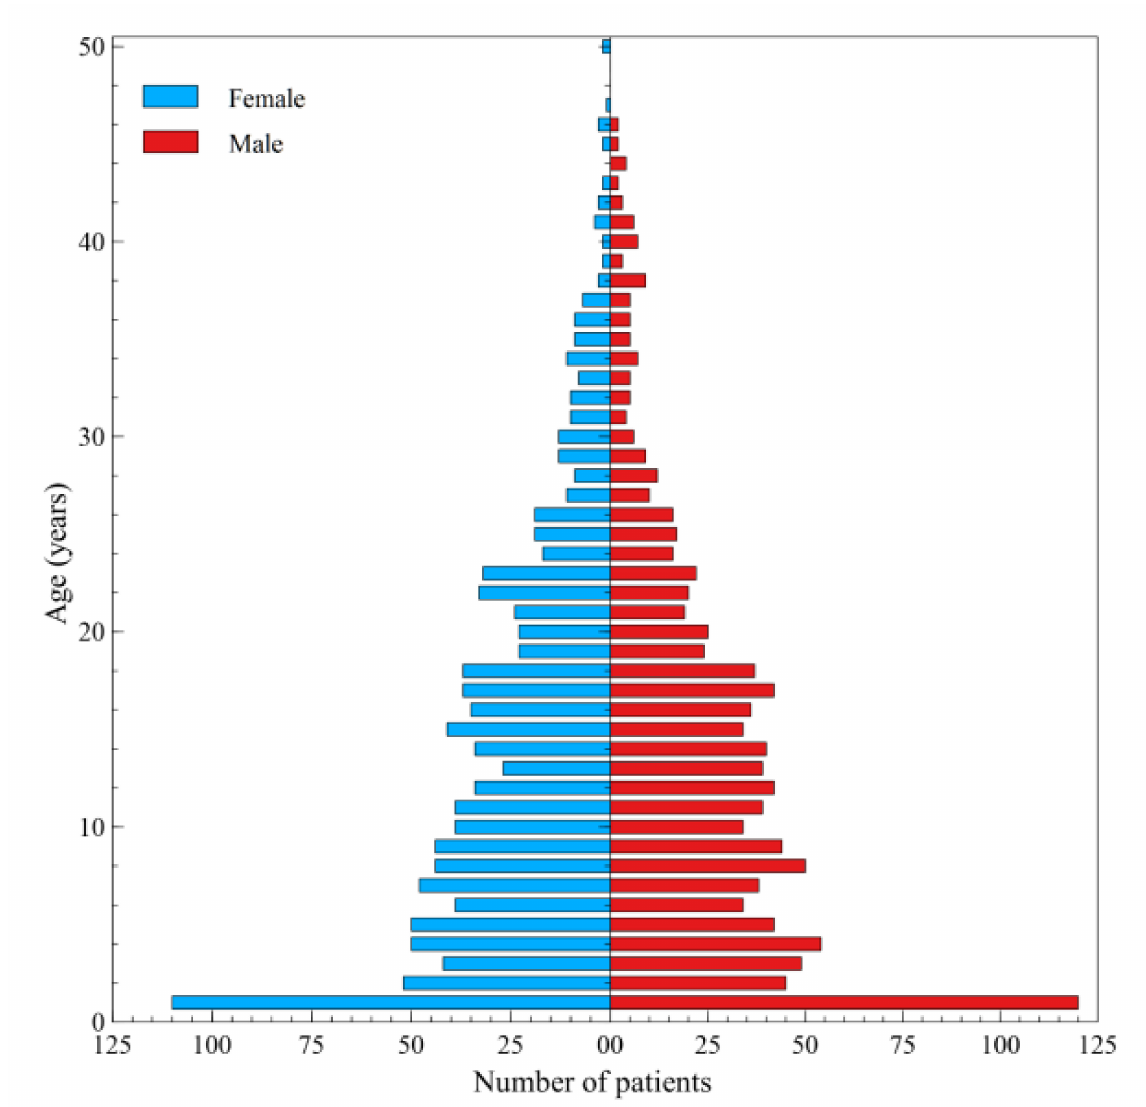
Figure 7. Distribution of hospital services according to the patient age and gender in